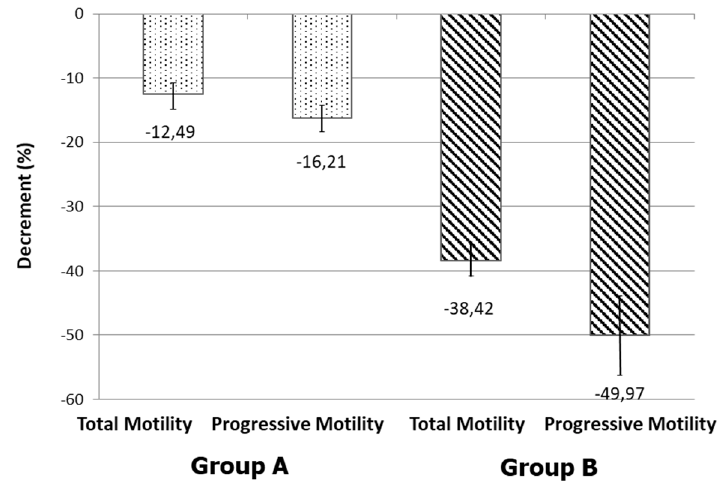
Figure 3. Decrease (mean of individual decrements ± standard deviation) in total and progressive motility of the two examined groups from T0 to